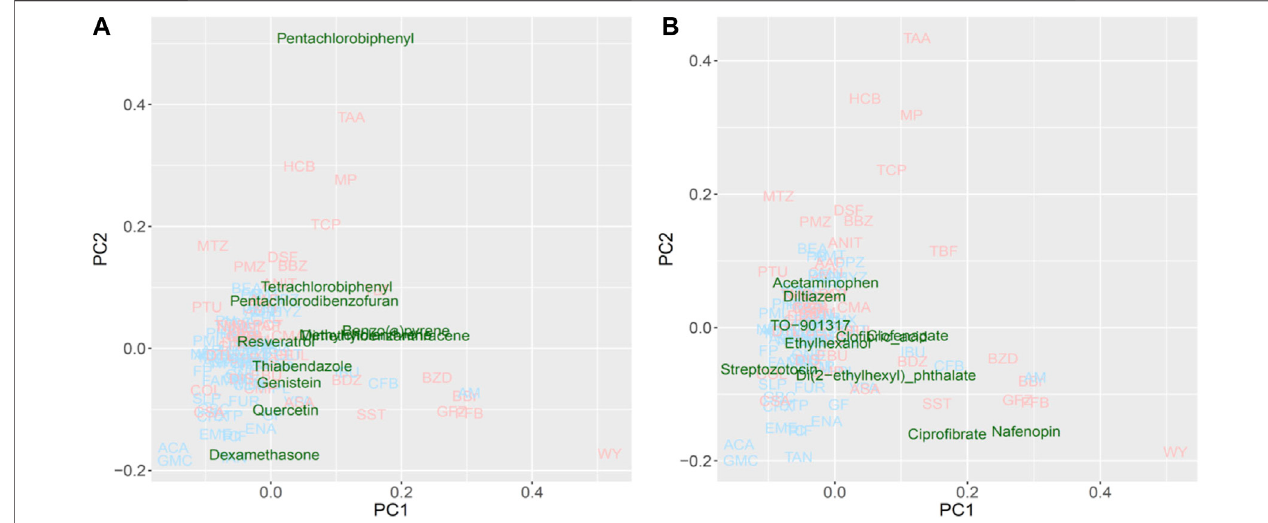
FIGURE 7 | Read-across using PCA plot of external data predicted by a virtual microarray (RAID). (A) Cyp1a and (B) Cyp4a inducing chemical substances were analyzed for validation.